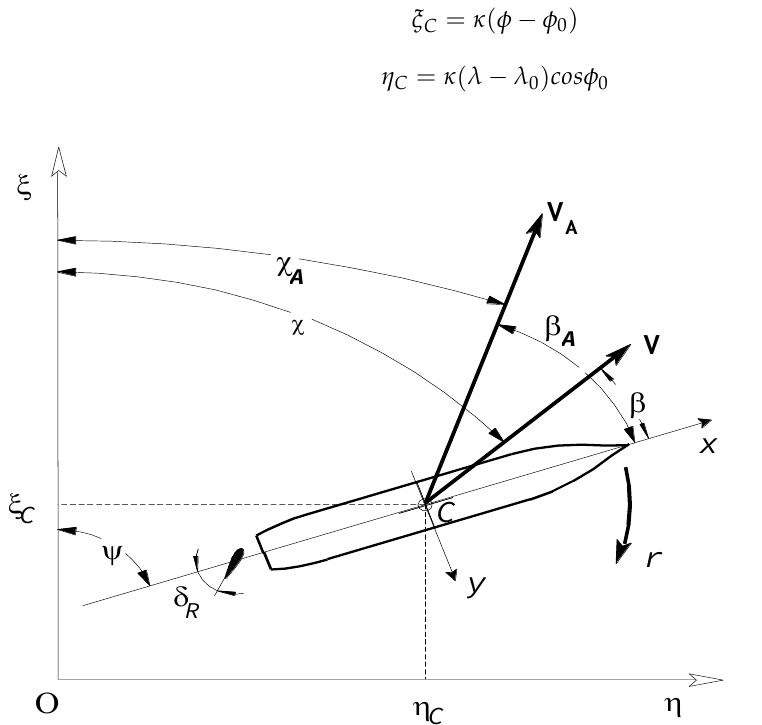
Figure 2. Definition of kinematic parameters (all shown quantities are